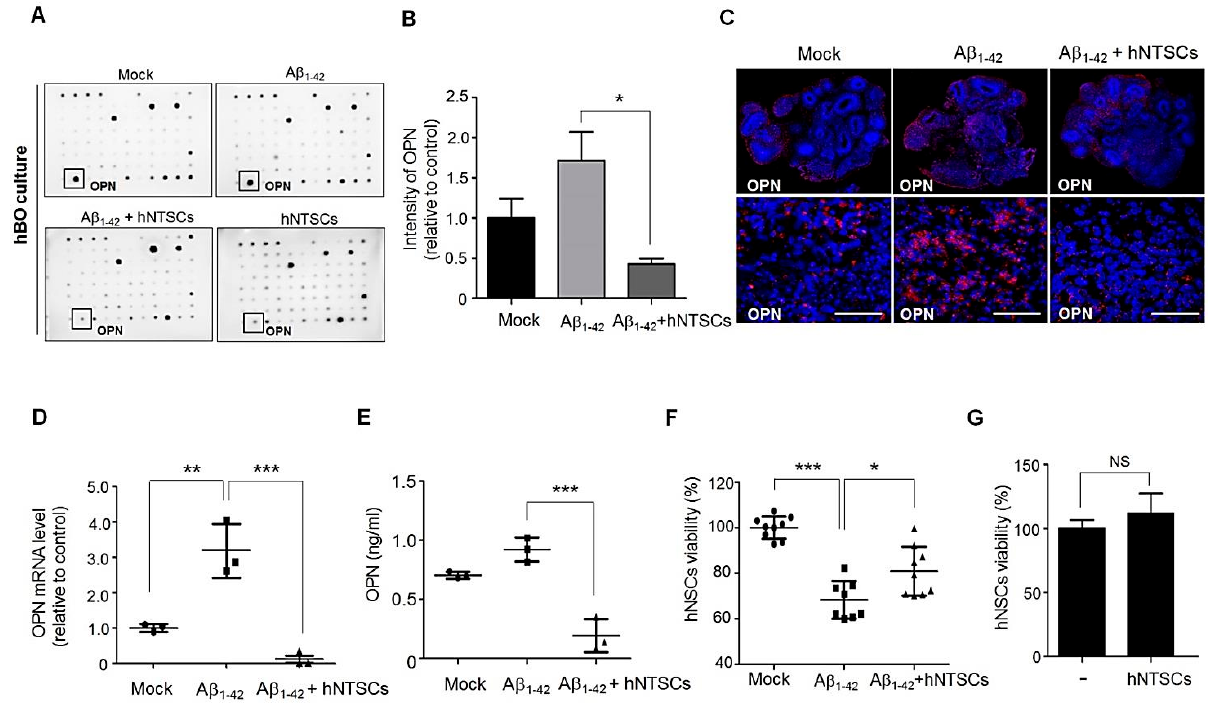
Figure 4. Cytokine analysis to identify a protein that is downregulated in the medium from hBOs cultured in the presence of A β 1–42 with hNTSC coculture. ( A ) Medium was collected from hBOs and hNTSCs cultured alone, hBOs cultured in the presence of A β 1–42 , and hBOs cultured in the presence of 10 μ M A β 1–42 with hNTSC coculture for 72–80 h. The cytokine secretion profile was analyzed by incubating the array membrane with the medium from hBO culture. The box shows downregulated proteins in the medium from hBOs cultured in the presence of A β 1–42 with hNTSC coculture. ( B ) The intensity of OPN spots in the array membrane was measured on the basis of grayscale levels. The values shown are the mean (SD). For nonparametric multiple comparison tests, one-way ANOVA was used to determine whether differences between groups were statistically significant. * p < 0.05. ( C ) Confocal microscopy images of hBOs cultured in the absence or presence of 10 μ M A β 1–42 with hNTSC coculture for 72–80 h after staining of OCT-embedded sections with antibodies against OPN (red). Nuclei were labeled with DAPI (blue). Scale bar: 50 μ m. ( D ) OPN mRNA expression was